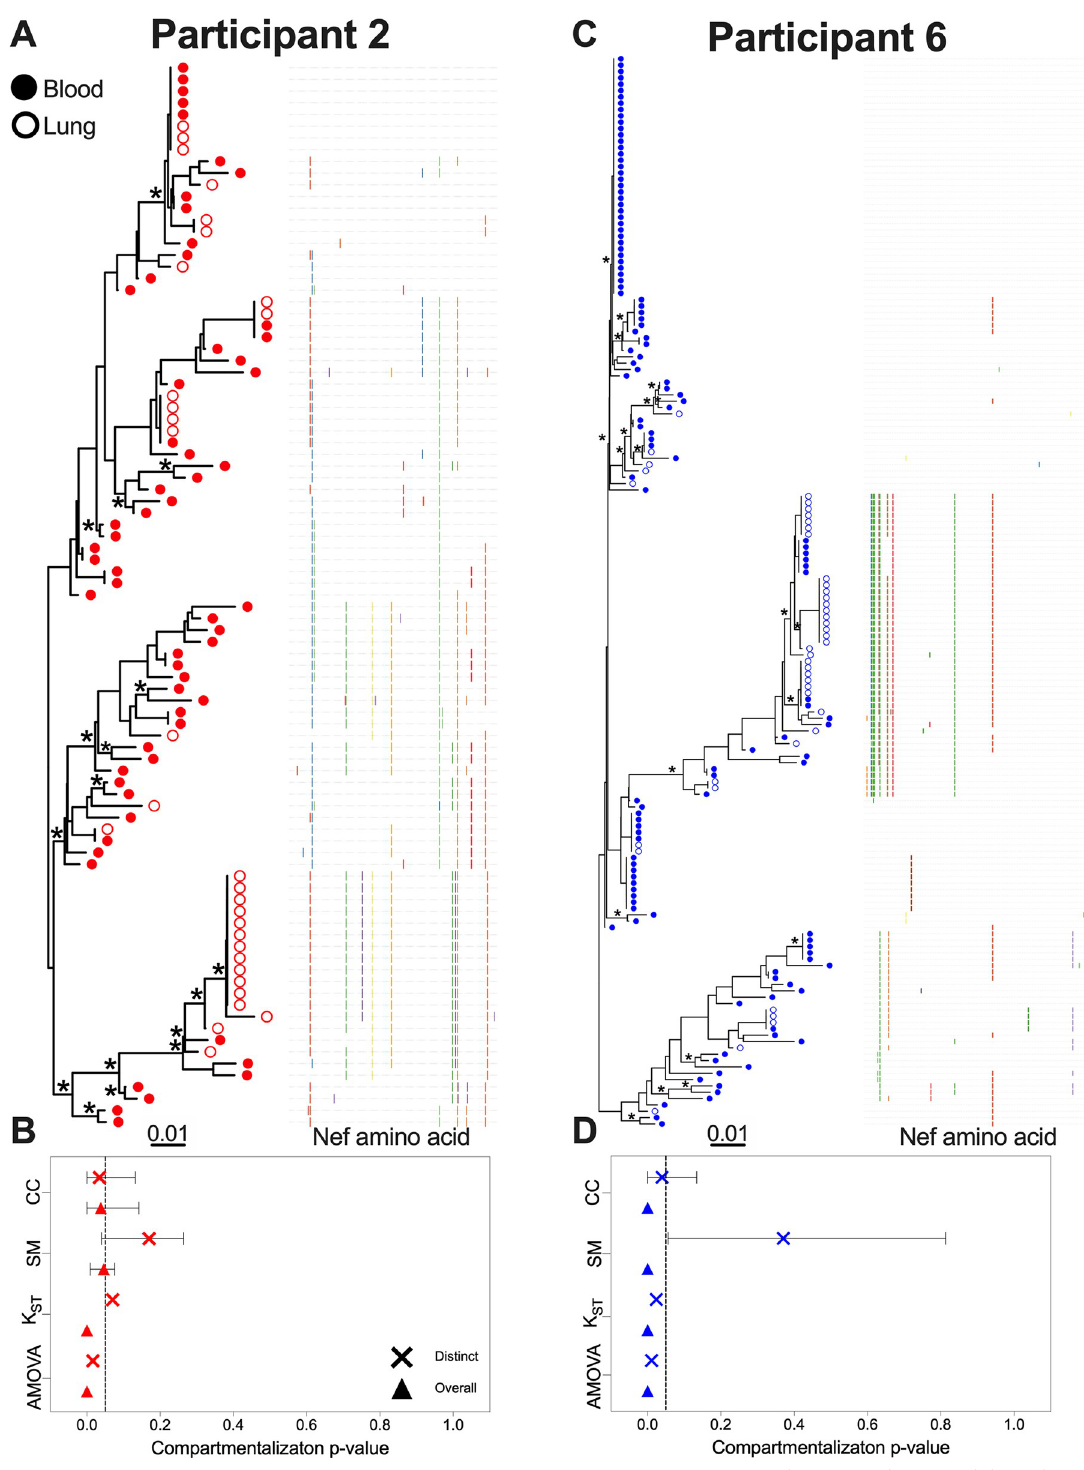
Fig 2. Within-host phylogenies and compartmentalization results for participants 2 and 6. Each participant’s top panel shows the highest likelihood phylogeny derived from Bayesian inference, rooted at the midpoint. Filled circles denote blood sequences; open circles denote lung sequences. Asterisks identify nodes supported by posterior probabilities � 70%. The adjacent plot shows amino acid diversity of each sequence, with coloured ticks denoting non-synonymous substitutions with respect to the sequence at the top of the phylogeny. The bottom panel shows p-values of the four tests of genetic compartmentalization between blood and lung